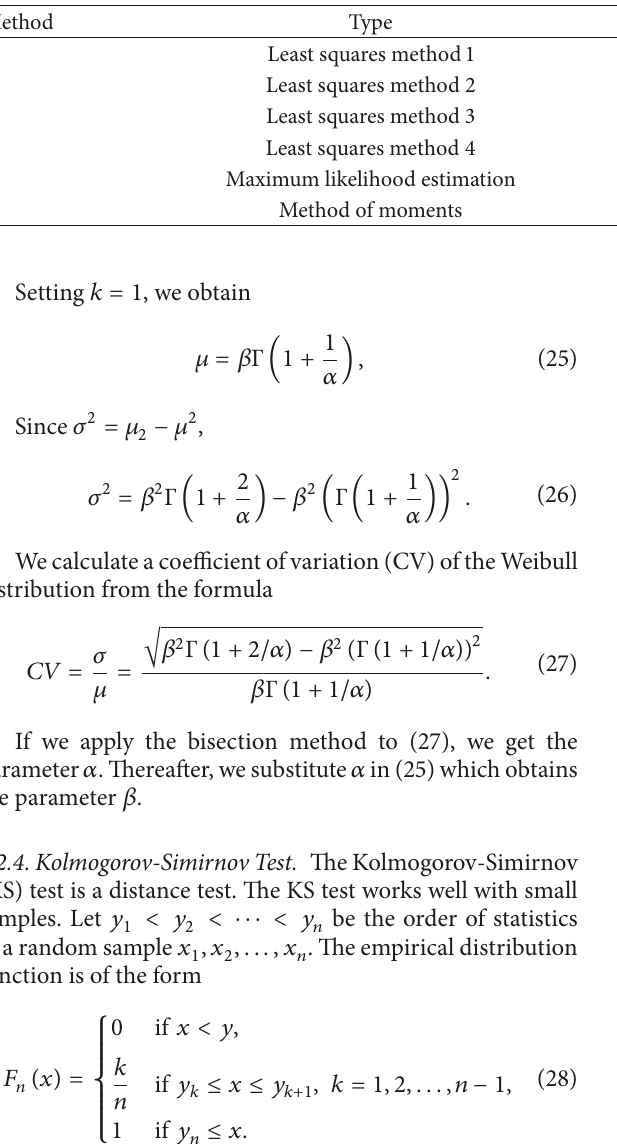
Table 2: Shape and scale parameters for a variety of estimation